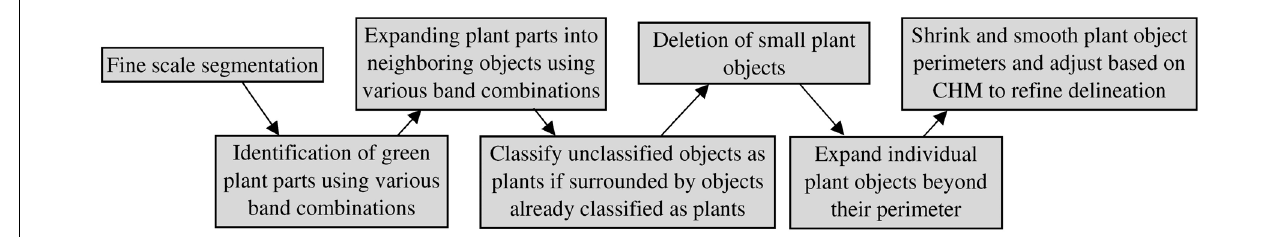
FIGURE 3 | Flowchart showing the individual steps in the object-based image analysis process used for delineating the tomato plants.